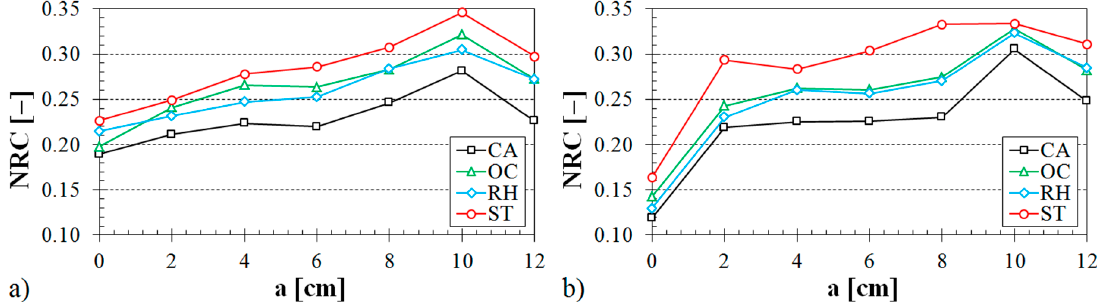
Figure 8. Influence of the 3D-printed ABS material structure on the noise reduction coefficient vs. air space size for the tested ABS samples: ( a ) volume ratio V r = 44%, sample thickness t = 3 cm; ( b ) volume ratio V r = 57%, sample thickness t = 2 cm.